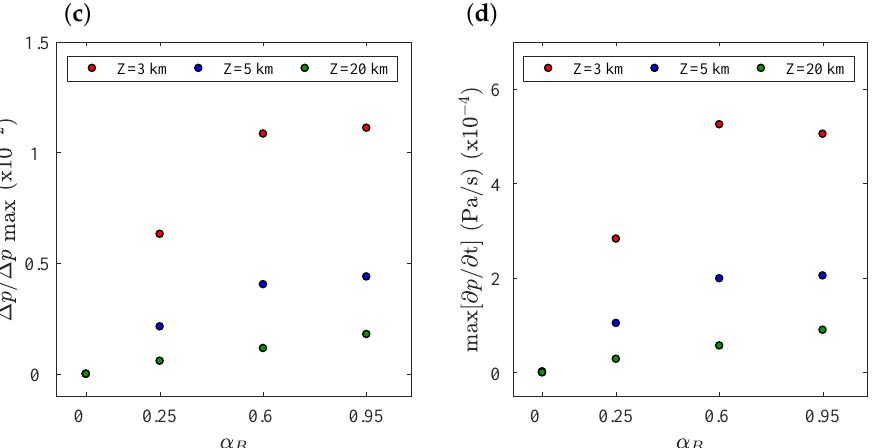
Figure 13. Impact of the poroelastic response on the pore pressure attenuation (left column) and ∂ p/ ∂ t (right column) at 3, 5 and 20 km depth. For panels ( a ) and ( b ) the fault permeability is k F = 10 − 11 m 2 , while for panels ( c ) and ( d ) is k F = 10 − 15 m 2 . When the fault is nearly impermeable, the poroelastic coupling is the main mechanism for the pore pressure diffusion in the fault. The remaining parameters of the simulations are detailed in Table 3. The regulation of the reservoir is